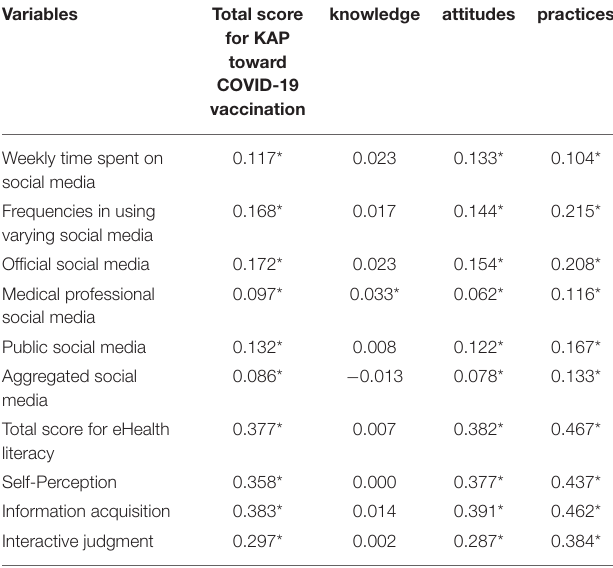
TABLE 3 | The correlation analysis for social media use, eHealth literacy, and KAP toward COVID-19 vaccination.